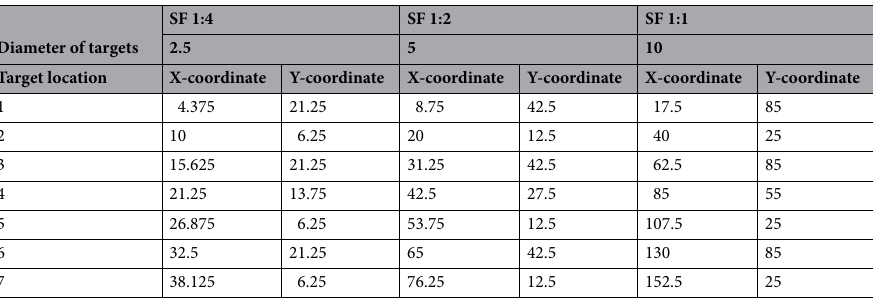
Table 1. Diameter of targets (in mm) and target locations (in mm) for different scaling factors (SFs).